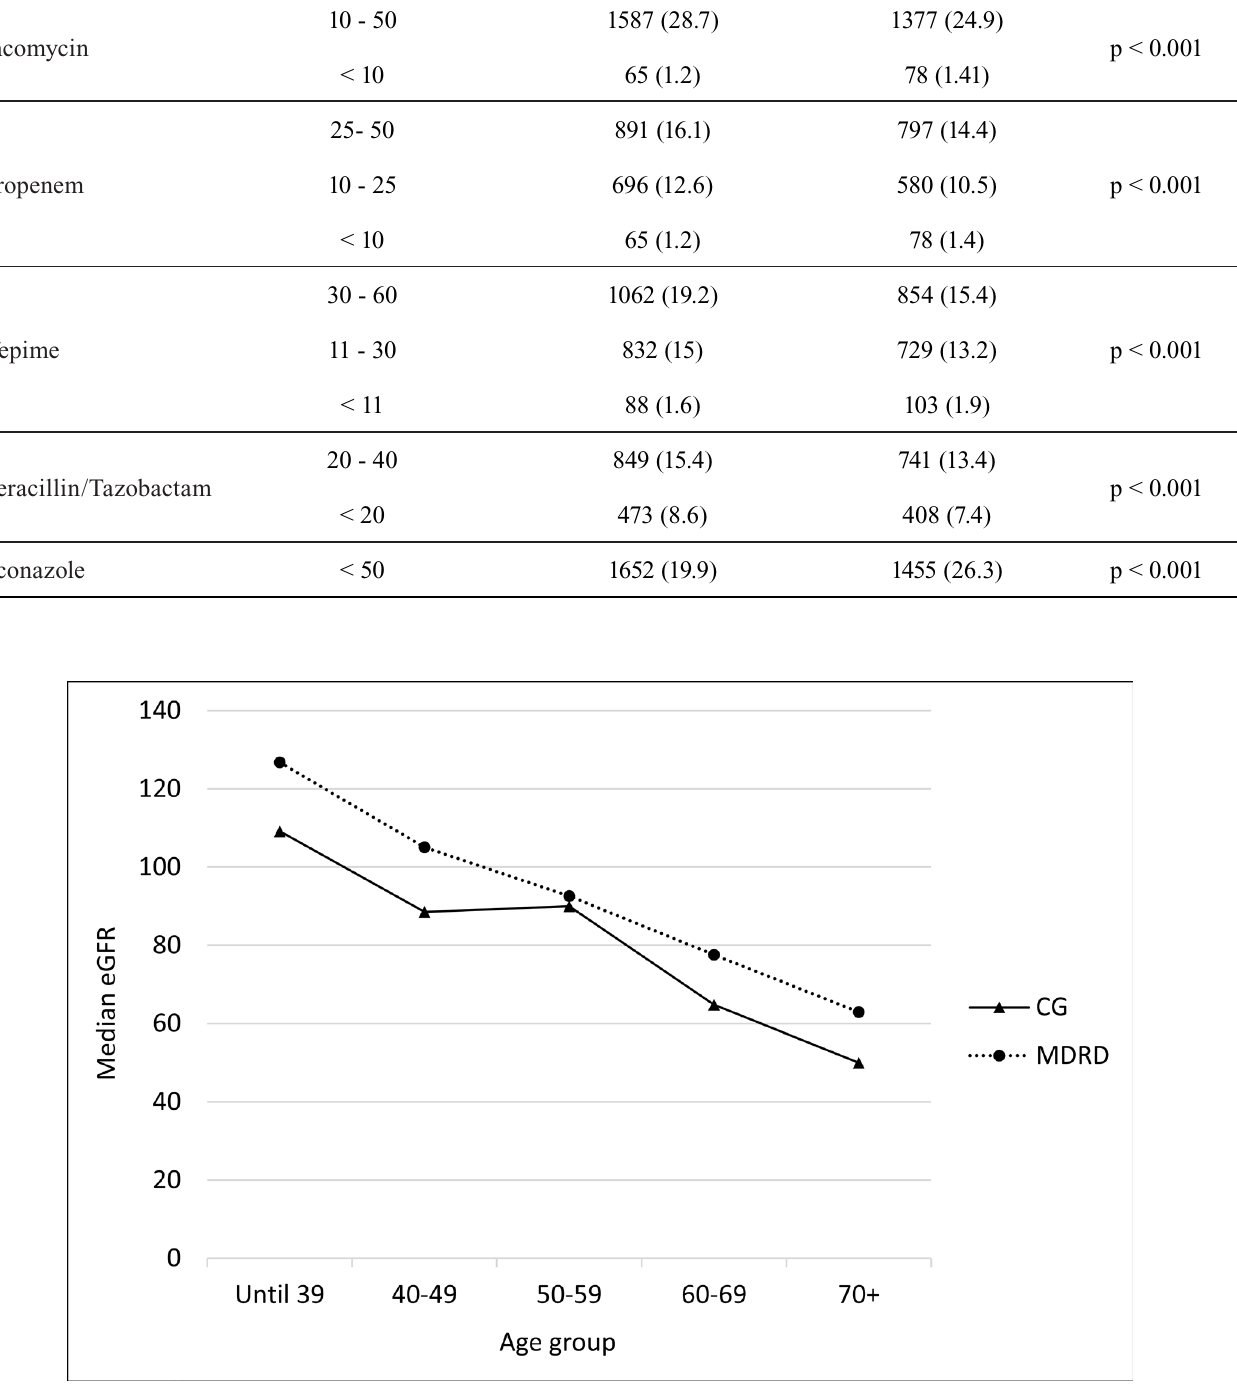
Figure 1 - Median estimated glomerular filtration rate calculated using MDRD-4 or Cockcroft-Gault versus age